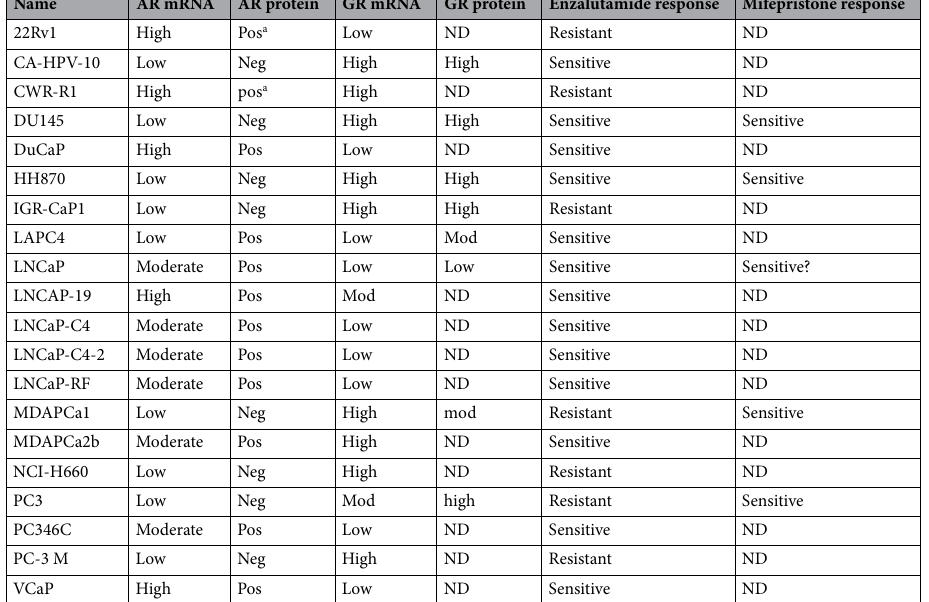
Table 2. Expression of androgen receptor and glucocorticoid receptor transcripts and proteins and their response to enzalutamide and mifepristone in prostate cancer cell lines. a CWR-R1 and CA-HPV-10 express high levels of AR transcript and protein but are known to harbor splice variants that impact enzalutamide response. Pos: positive expression; Mod: moderate expression; Neg: negative expression; ND not